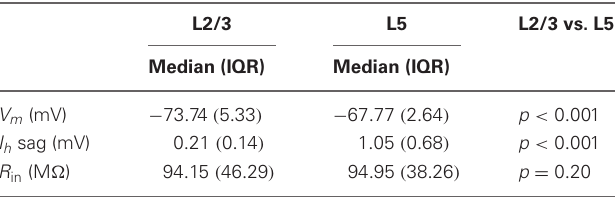
Table 2 | Passive properties of in vitro recorded L2/3 ( n = 12) and L5 ( n = 12)